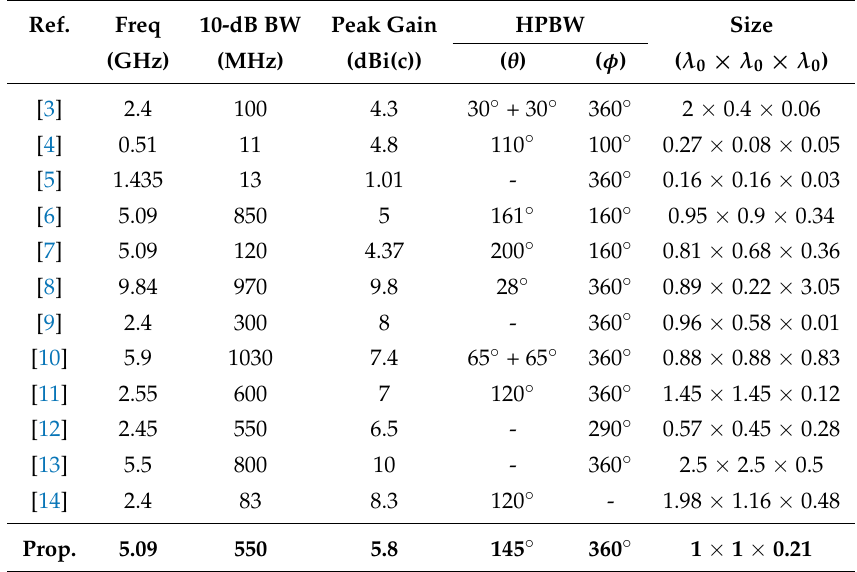
Table 2. Performance comparison between the previous works and the proposed array about beam-reconfigurable antennas